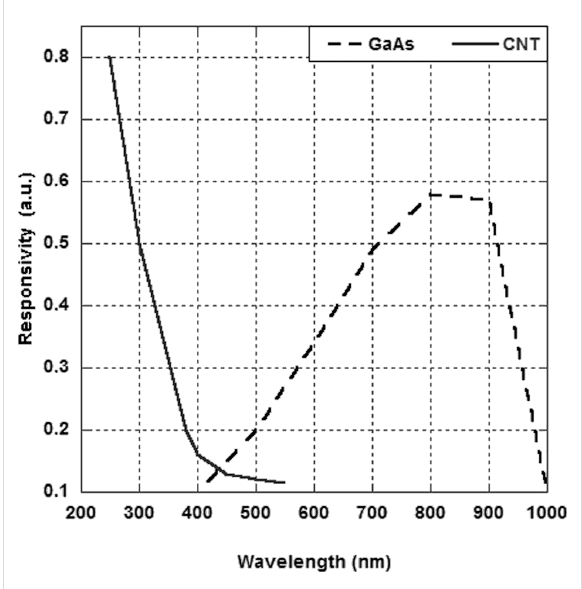
Figure 7: Responsivity trend of GaAs and CNTs based photodetec- tors.